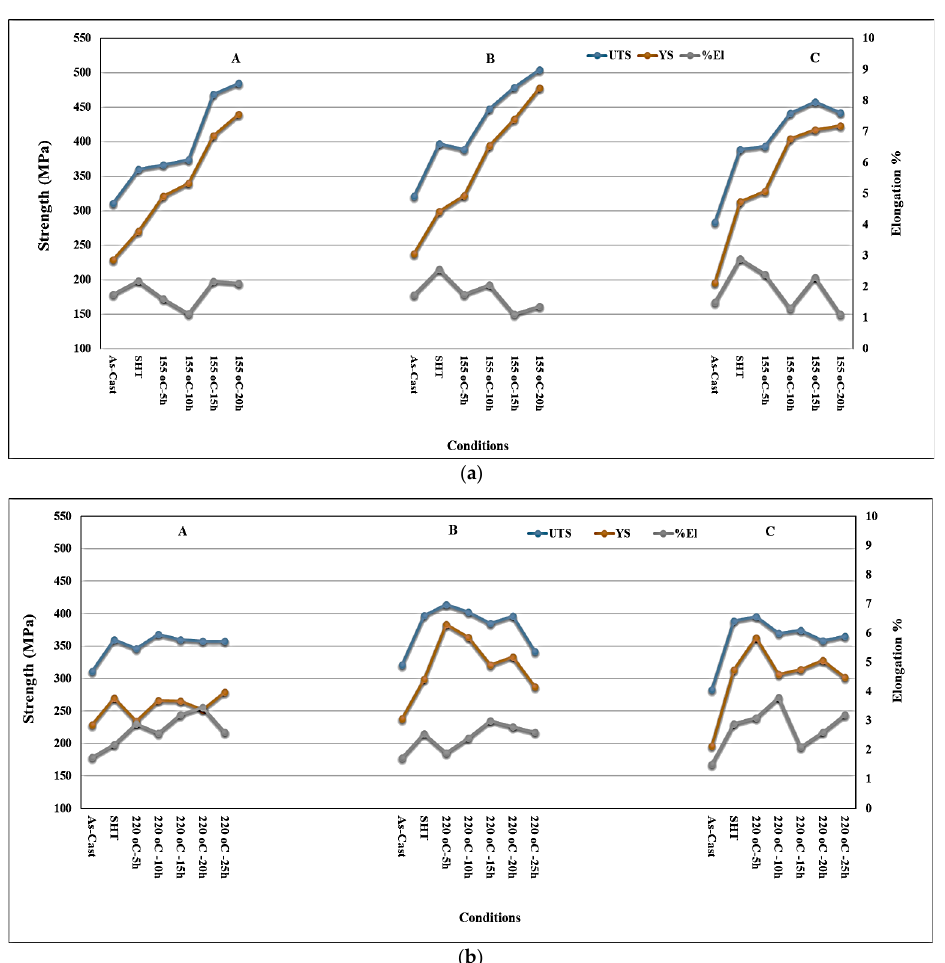
Figure 12. Variation in the alloy tensile properties as a function of the heat treatment condition: ( a ) aging temperature of 155 °C, and ( b ) aging temperature of 220 °C.